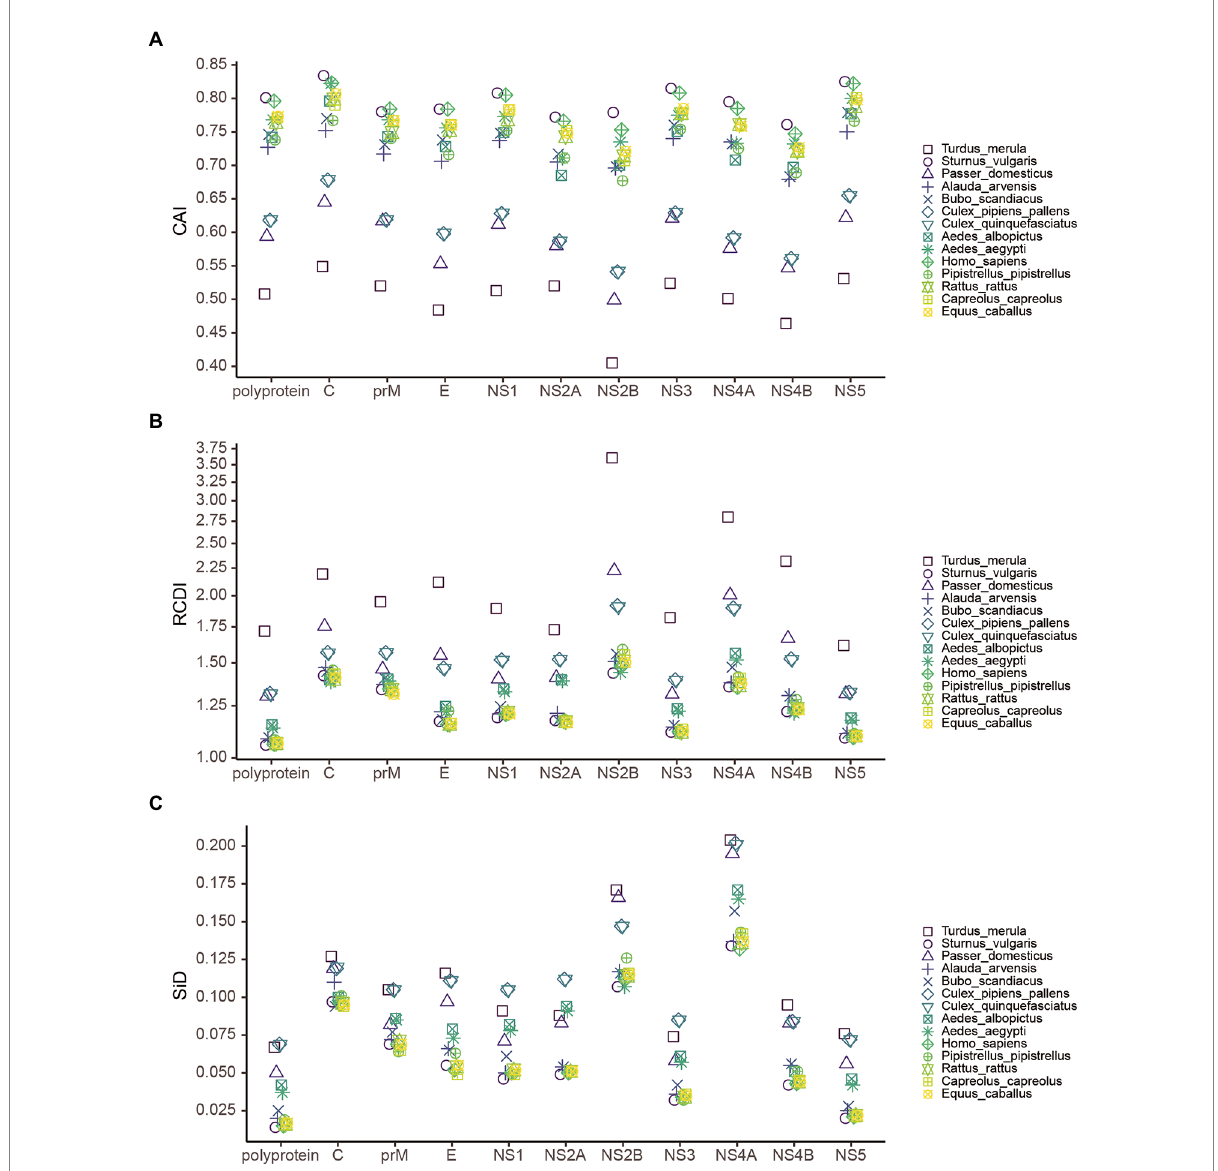
FIGURE 8 The measure of overall USUV adaption to various potential hosts. (A) Codon adaption index (CAI), (B) Relative codon deoptimization index (RCDI), and (C) The similarity index (SiD) analysis of the codon usage between USUV coding sequences and their hosts. Different reference hosts are depicted in distinct shapes and